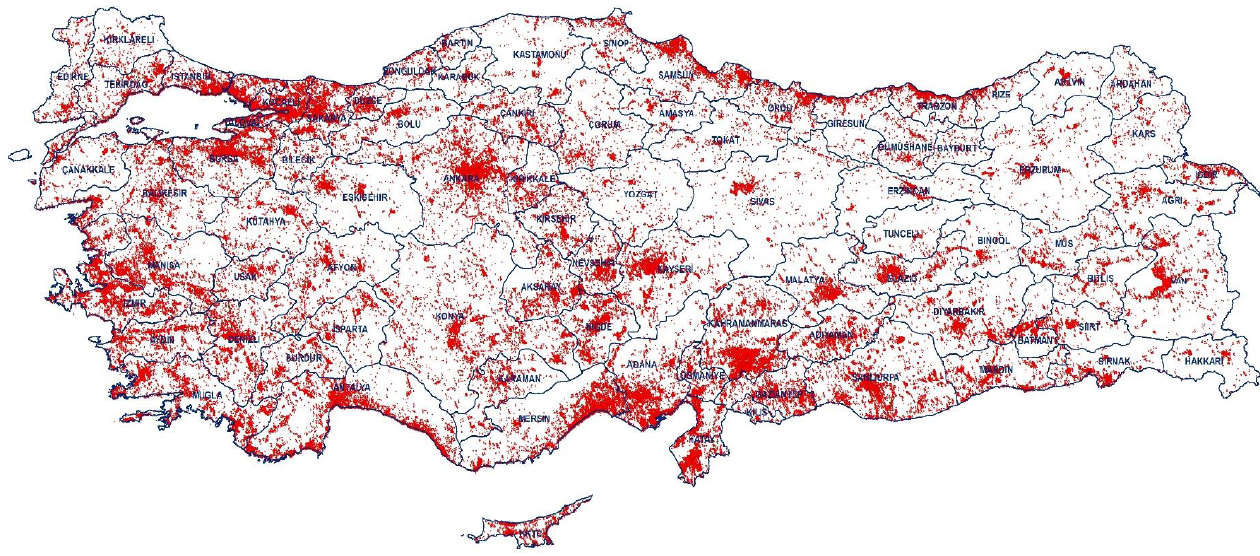
Figure 9. CORS-TR network usage map (Source: https://tkgm.gov.tr (accessed on 20 September